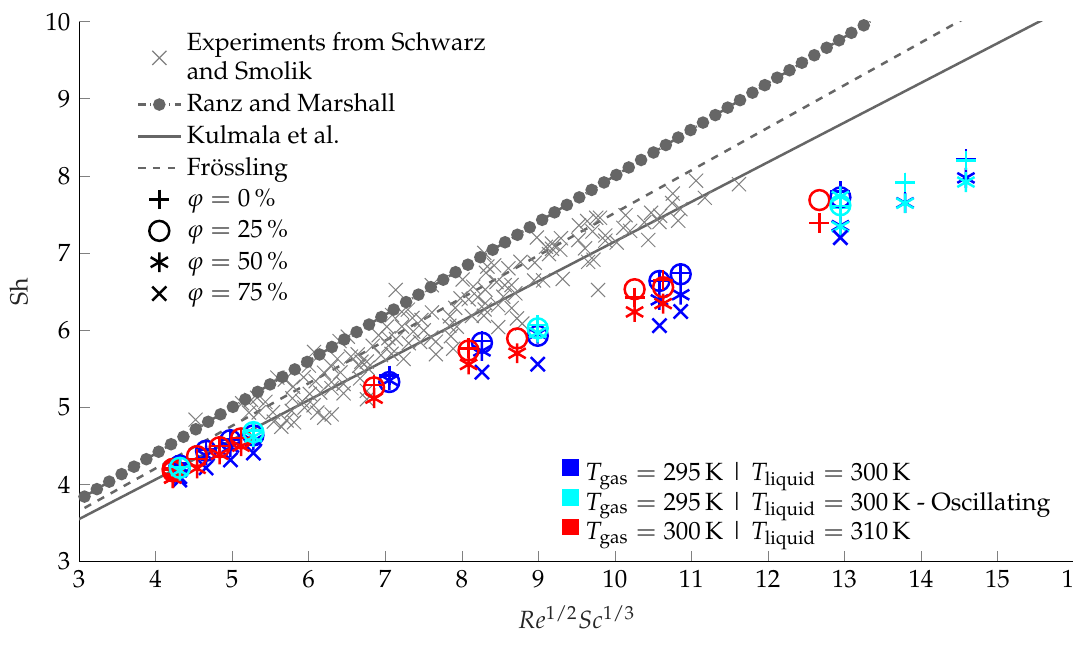
Figure 11. Sh over Re 1/2 Sc 1/3 : Experimental results [21] and correlations from the literature ([5–7]) plotted together with results from simulations with a resolution of 26 cells per